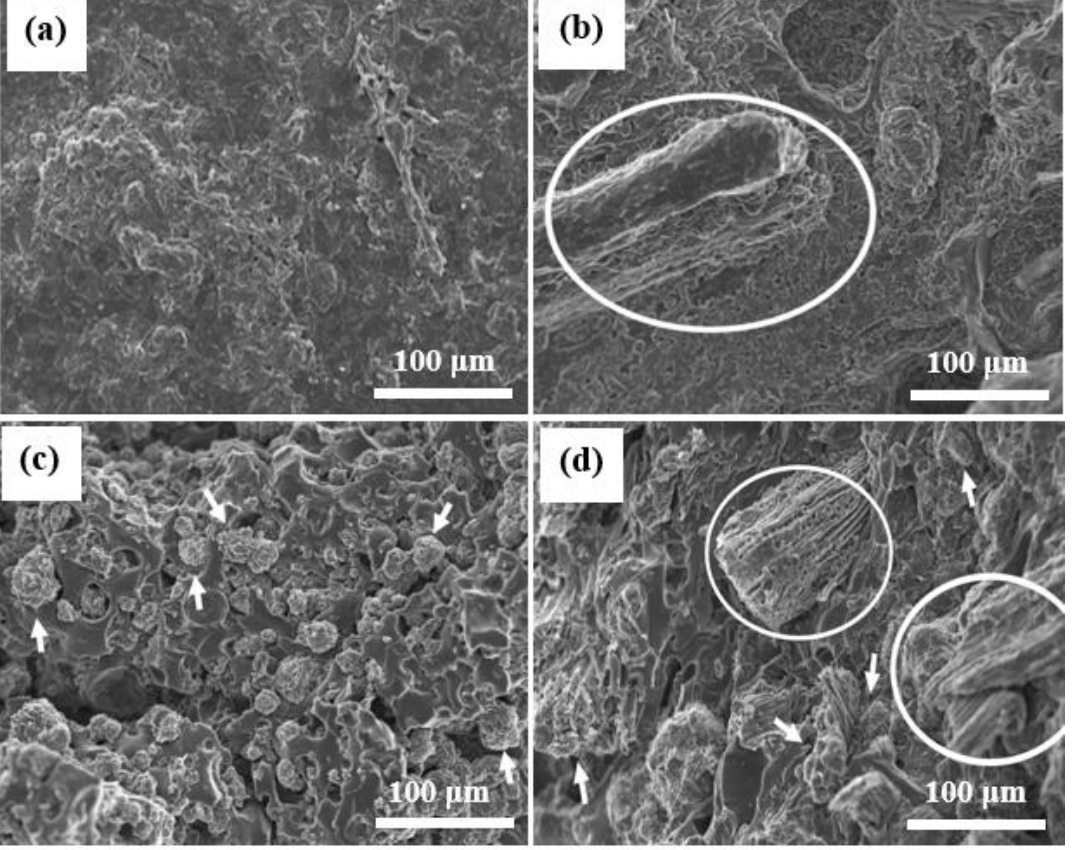
Figure 1. FESEM images of: ( a ) PVA hydrogel, ( b ) oil palm bio-waste (OPB)/PVA hydrogel, ( c ) multiwalled carbon nanotubes (MWCNTs)/PVA hydrogel and ( d ) OPB/PVA/MWCNTs and ( e ) high resolution of OPB/MWCNTs hydrogel, respectively. 3.2. BET Surface Area Analysis To further understand the impact of OPB and MWCNTs, BET analysis was performed and the results are shown in Table 2. The addition of MWCNTs and OPB has significantly improved the accessible porosity and pore diameter of OPB/MWCNTs reinforced PVA hydrogel, which was directly associated to the adsorption performance of Pb(II) onto the surface of the PVA hydrogels. These characteristics allowed the water molecules to penetrate the hydrogel and resulted in a high- water uptake capacity. The non-reinforced PVA hydrogel possessed a higher surface area as